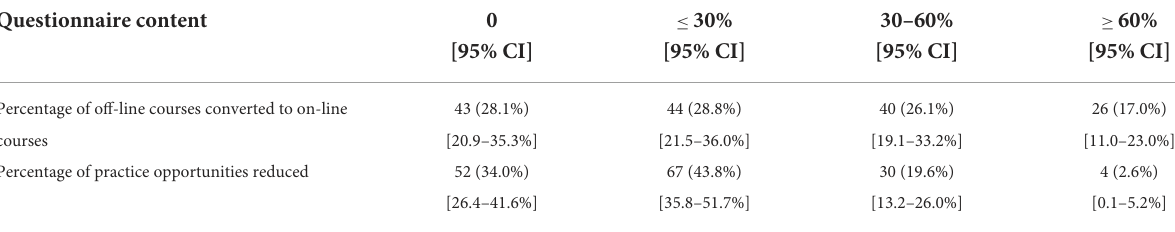
TABLE 4 The impact of the COVID-19 Pandemic on medical graduate courses.